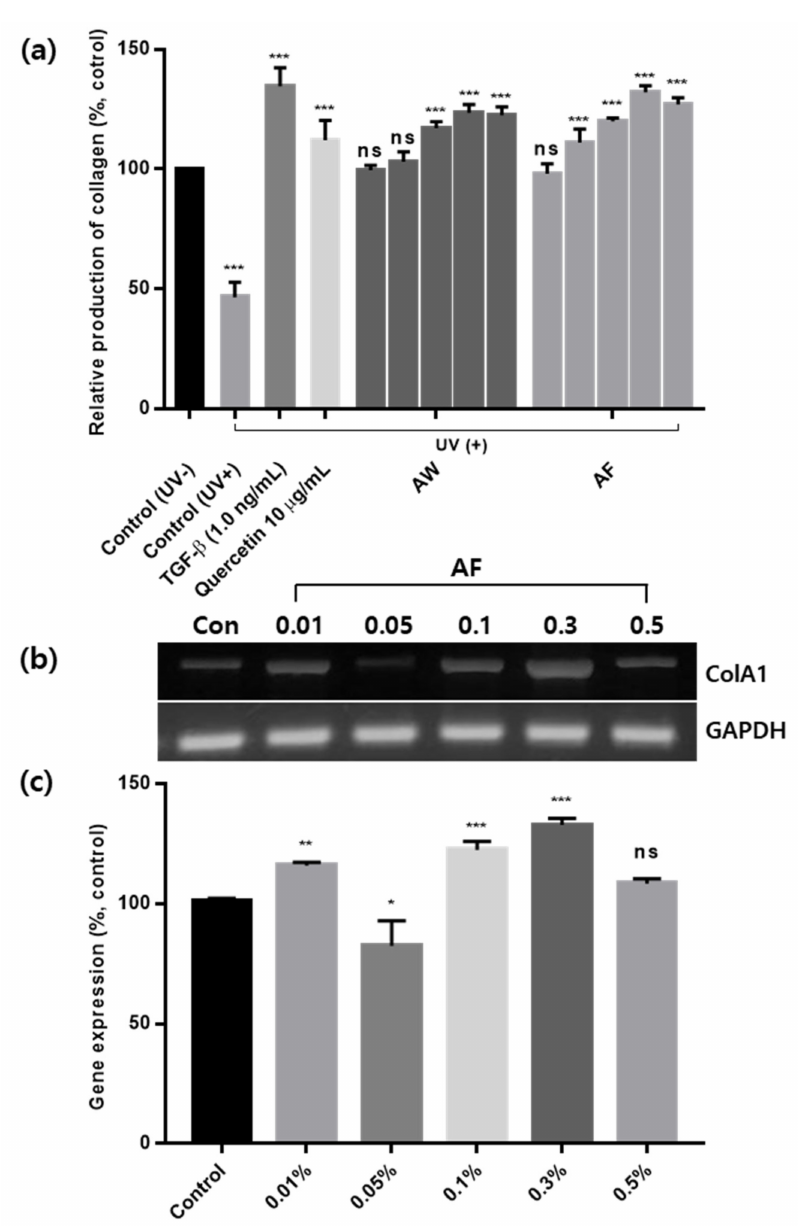
Figure 8. Collagen levels in UV b -irradiated human skin fibroblasts treated with 10 µ g/mL quercetin and various concentrations of the two different extracts ( a ) along with the densitometric intensities ( c ) corresponding to each PCR band ( b ). AW: hot water extraction of Aloe vera leaf skin at 100 ◦ C for 24 h. AF: L. plantarum fermentation of Aloe vera leaf skin at 37 ◦ C for 3 days and extraction with an ultrasonicator at 40 kHz for 1 h at room temperature. The mean values ± SD for separate triplicate experiments are shown, and error bars indicate the SD. The significance of the difference was set to * p < 0.05, ** p < 0.01 and *** p < 0.001 compared with the control